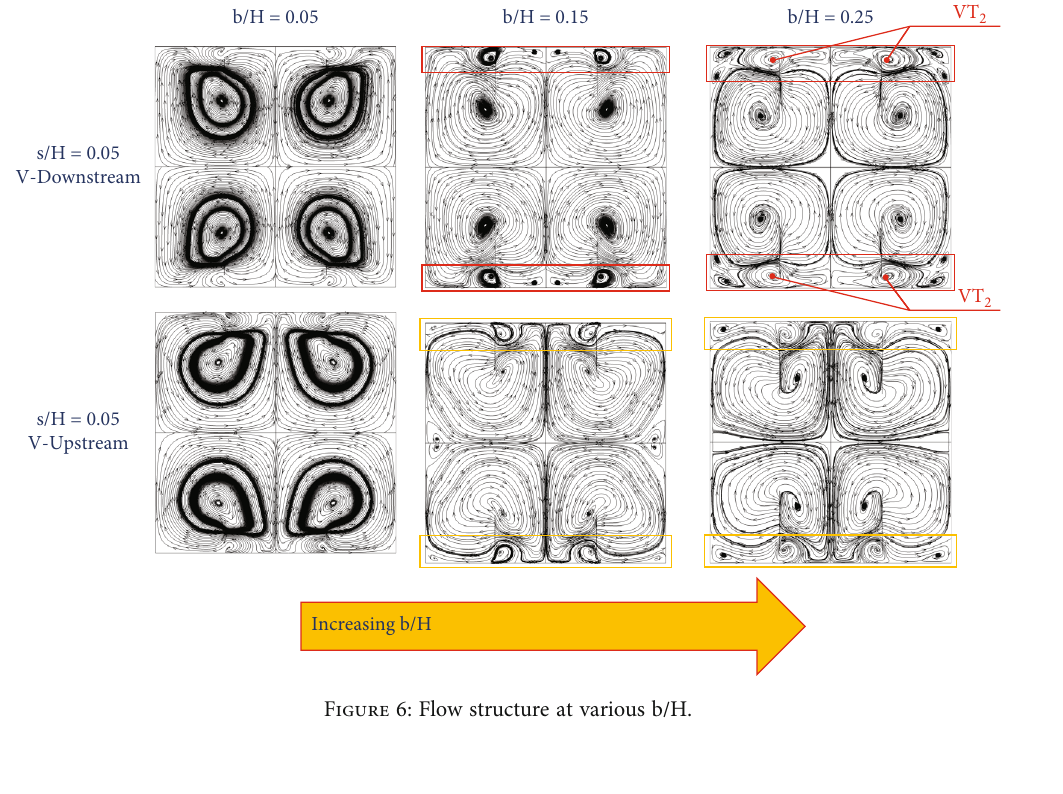
Figure 6: Flow structure at various